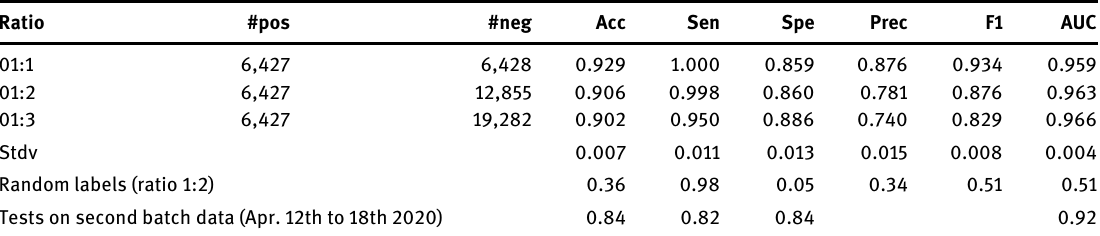
Table 2: National Israeli COVID-19 DNA tests performed until Apr. 11, 2020, without the ‘‘Test Indication’’ feature (first batch). Average results obtained from 100